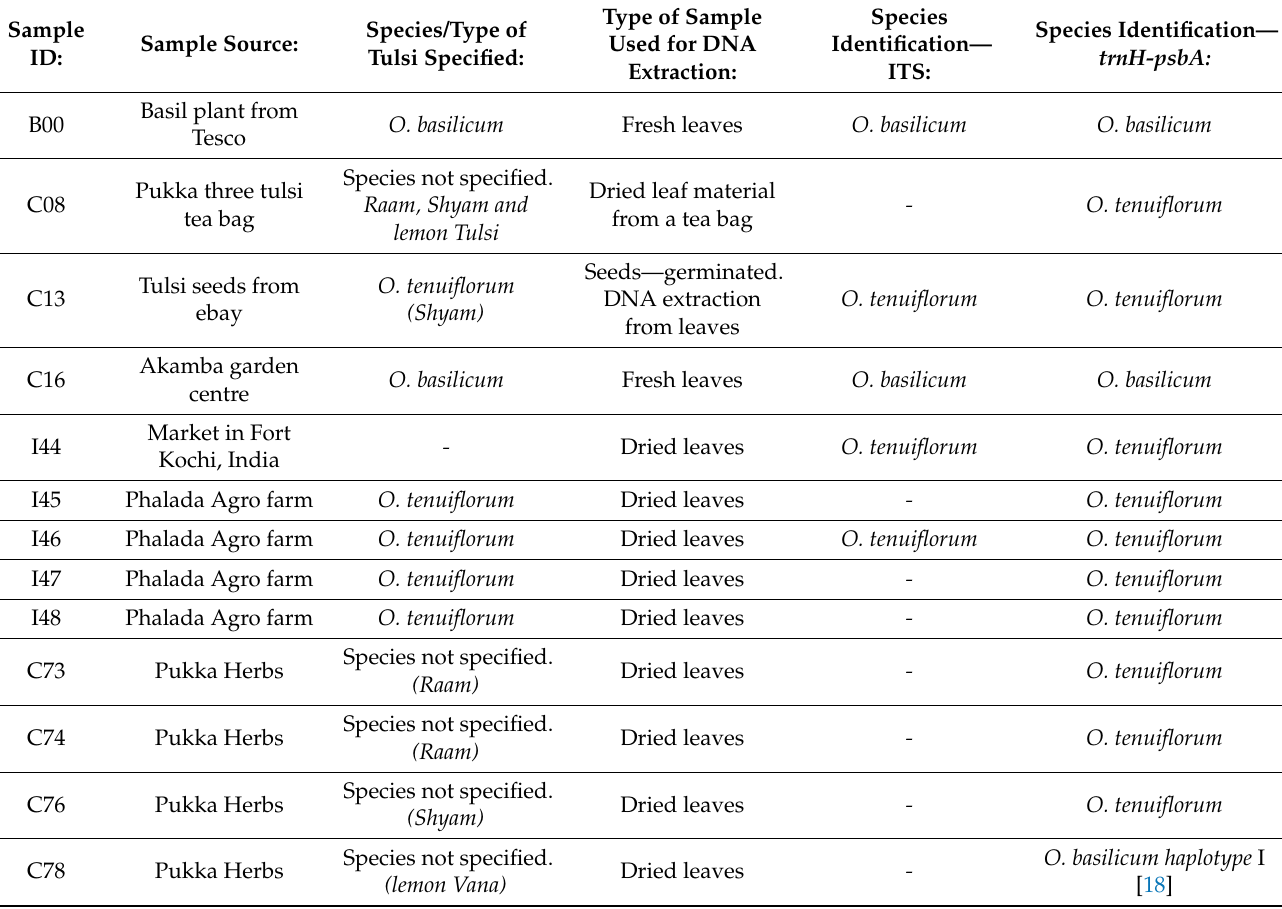
Table 3. Commercial Tulsi samples species identification